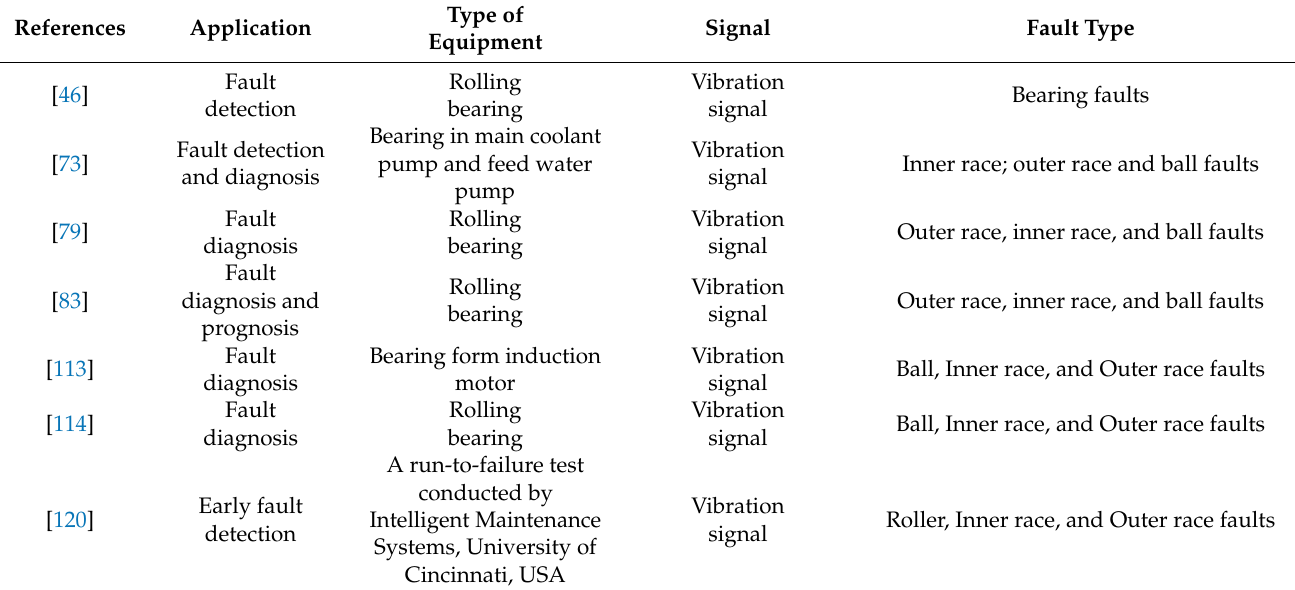
Table 15. Bearing condition monitoring using support vector